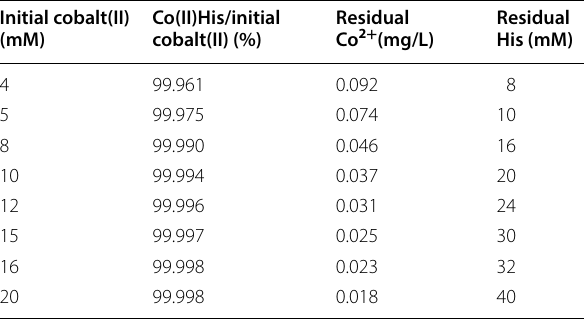
The equilibrium constant under 30 °C was not publicly available, thus the constant was referred from 24 °C